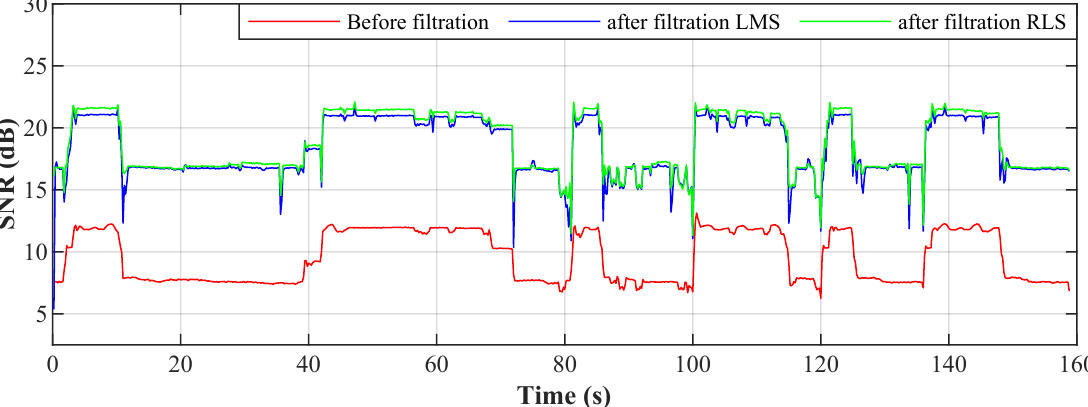
Figure 25. Signal-to-Noise Ratio (SNR) values at intervals of 200